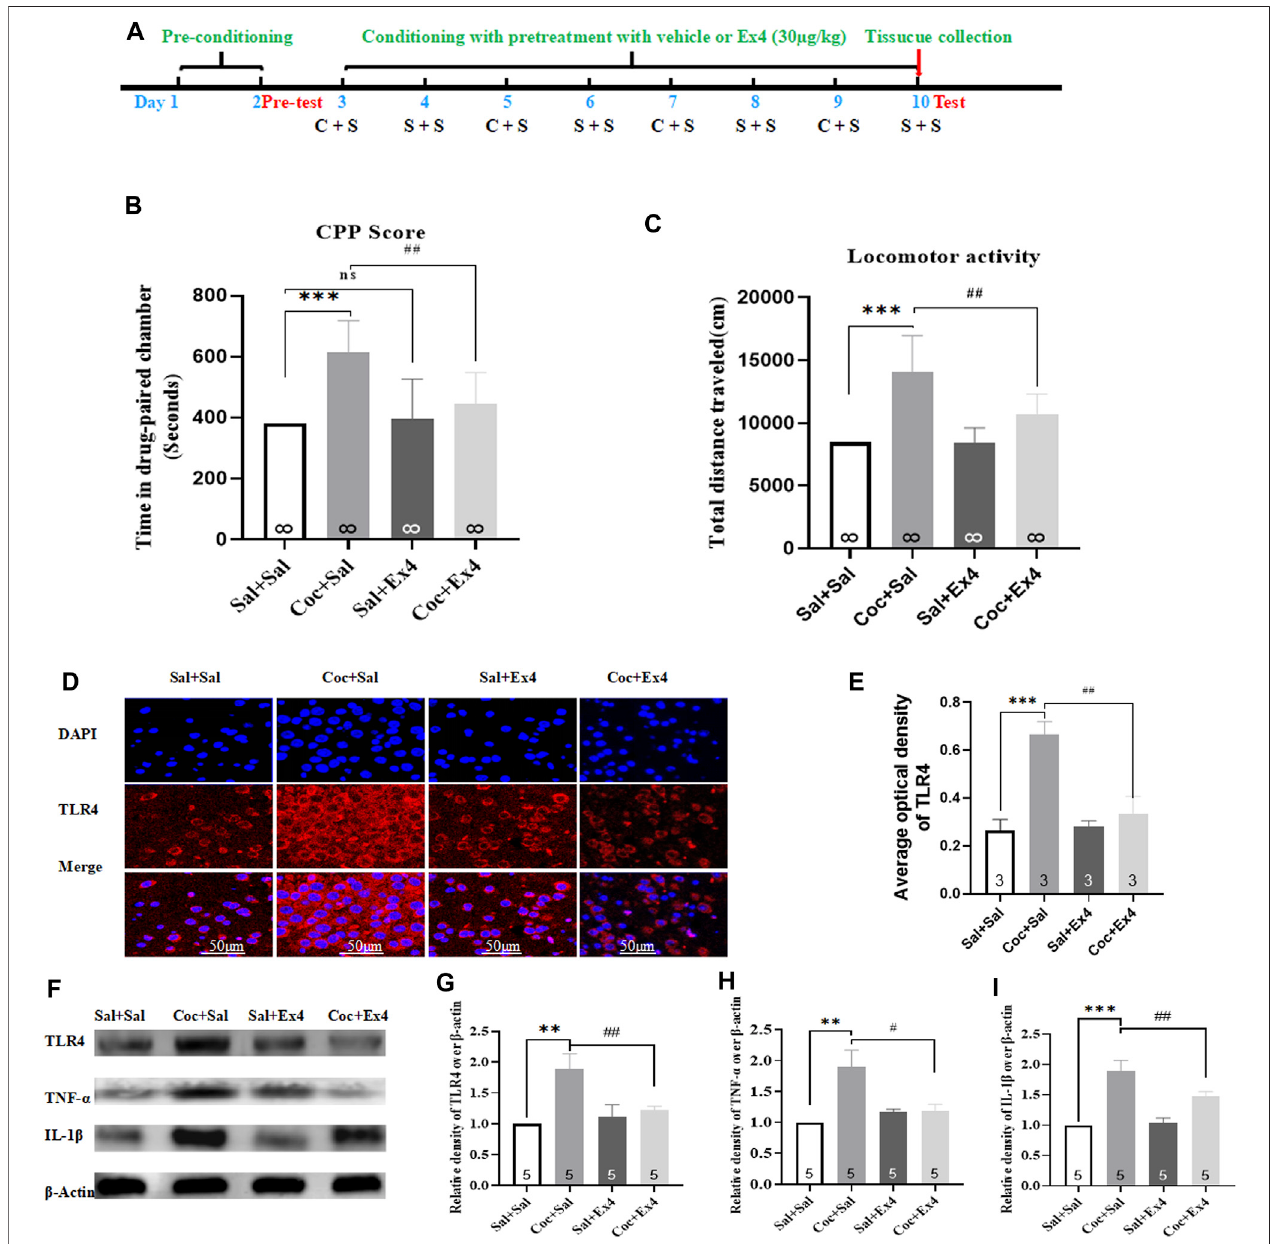
FIGURE 5 | Ex4 ’ s pretreatment inhibits the acquisition of cocaine-induced CPP and alleviates expression levels of TLR4, TNF- α and IL-1 β . (A) The experimental schedule for saline (S) as well as cocaine (C) and exendin-4 treatment. (B) CPP scores following cocaine conditioning with systemic treatment with saline and Ex4 (30.0 μ g/kg)showthatcompared toSal+Salgroupcocaineinducedasigni fi cantCPP thatwaslessened byEx4treatment.***represents p < 0.001vsSal+Sal, ## represent p < 0.01 vs Coc+Sal, ns represents no signi fi cant difference, one-way ANOVA followed by a Bonferroni ’ s post hoc test. (C) Locomotor activity following cocaine conditioningwithsystemicpretreatmentwithsalineandEx4(30.0 μ g/kg)showthatahyperactivityinducedbycocainewasreducedbyEx4treatment.***represents p < 0.001vsSal+Sal, ## represent p < 0.01vsCoc+Sal,one-wayANOVAfollowedbyaBonferroni ’ s posthoc test. (D) Representativeimagesofimmuno fl uorescentstaining with TLR4 (red), and DAPI (blue) in the hippocampus from the different groups (scale bar (cid:2) 50 μ m). Systemic administration of Ex4 diminished fl uorescence density of TLR4 up-regulated by cocaine exposure ( n (cid:2) 3 in each group). (E) Semiquantitative analysis of the relative density of TLR4 by densitometric analysis in different groups. *** represents p < 0.001 vs Sal+Sal, ## represent p < 0.01 vs Coc+Sal, one-way ANOVA followed by a Tukey ’ s post hoc test. (F) Representative immunoblots of TLR4, TNF- α andIL-1 β proteinsindifferentgroups( n (cid:2) 5ineachgroup). (G) SemiquantitativeanalysisoftherelativelevelsofTLR4bydensitometricanalysisindifferentgroups. ***represents p < 0.001 vsSal+Sal, ## represent p < 0.01 vsCoc+Sal, one-way ANOVA followedbyaTukey ’ s posthoc test. (H) Semiquantitativeanalysis oftherelative levels ofTNF- α bydensitometric analysisin different groups. ** represents p < 0.01vs Sal+Sal, # represent p < 0.05 vs Coc+Sal, one-way ANOVA followed byaTukey ’ s posthoc test. (I) Semiquantitative analysisoftherelativelevelsofIL-1 β bydensitometricanalysisindifferentgroups.***represents p < 0.001vsSal+Sal, ## represent p < 0.01 vs Coc+Sal, one-way ANOVA followed by a Tukey ’ s posthoc test. All data are presented as the mean ± SEM. Sal indicates saline. Coc indicates cocaine. Ex4 indicates Exendin-4.